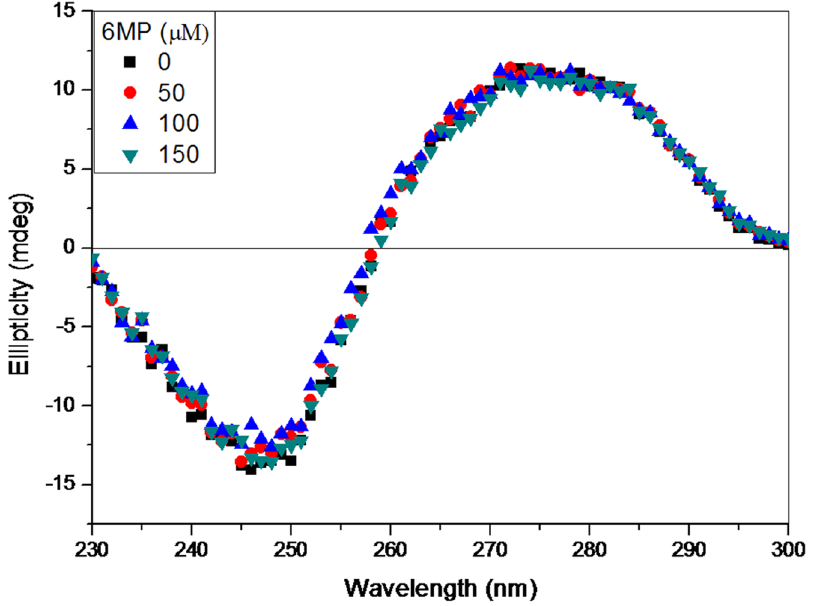
Figure 7. Effect of 6MP on CD spectra of CT-DNA. CD spectra of CT-DNA (30 m M) in 10mM Tris-HCl (pH 7.2) with the addition of varying concentration of 6MP. Each spectrum was obtained at 25 u C with a 10 mm path length cell.